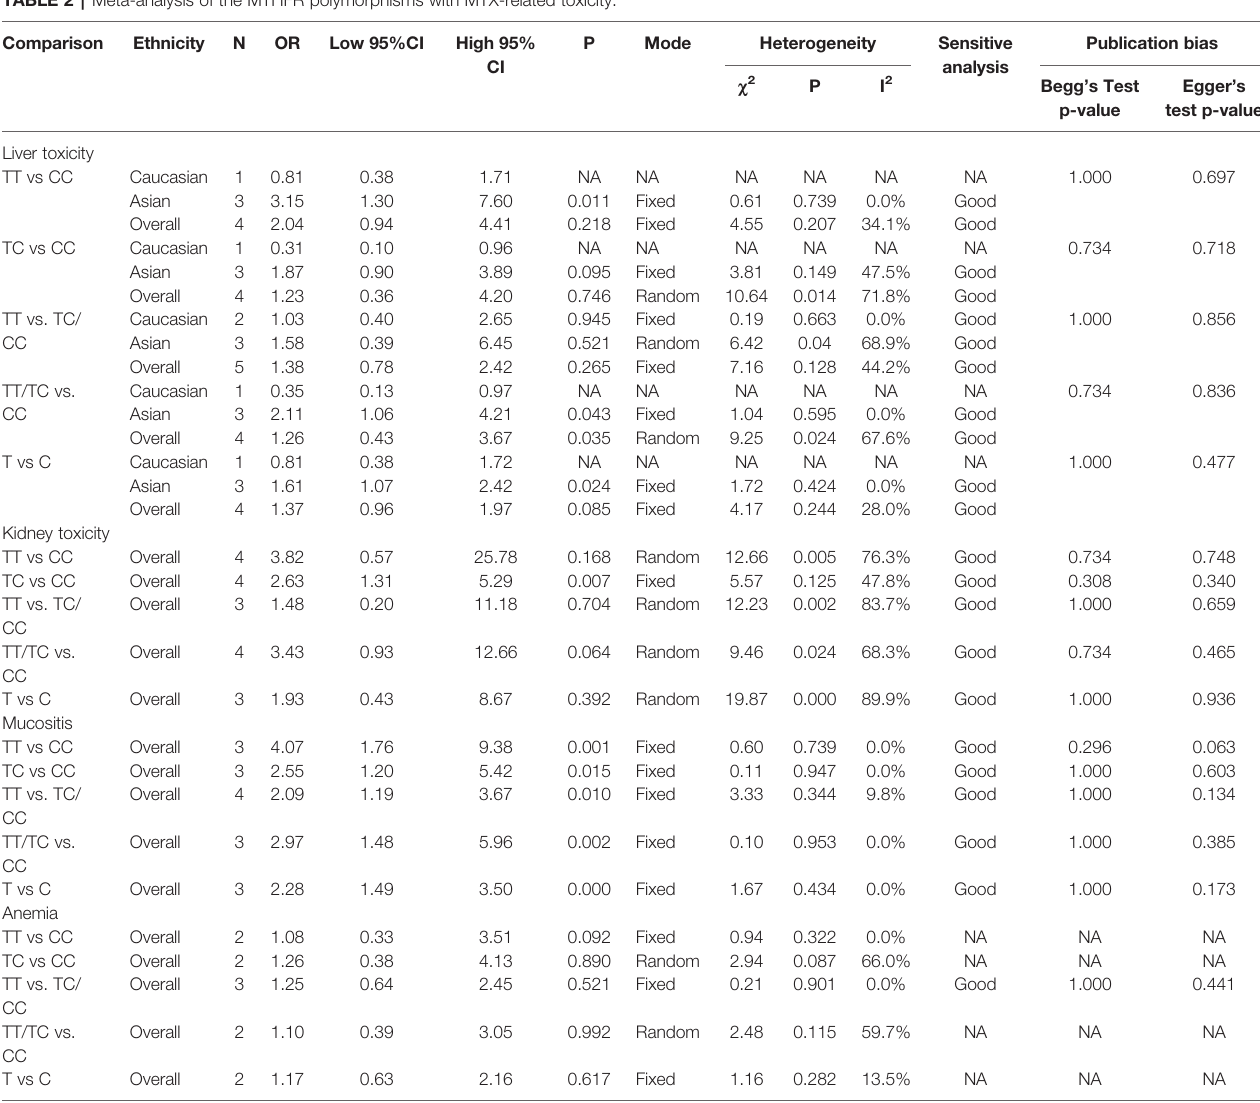
TABLE 2 | Meta-analysis of the MTHFR polymorphisms with MTX-related